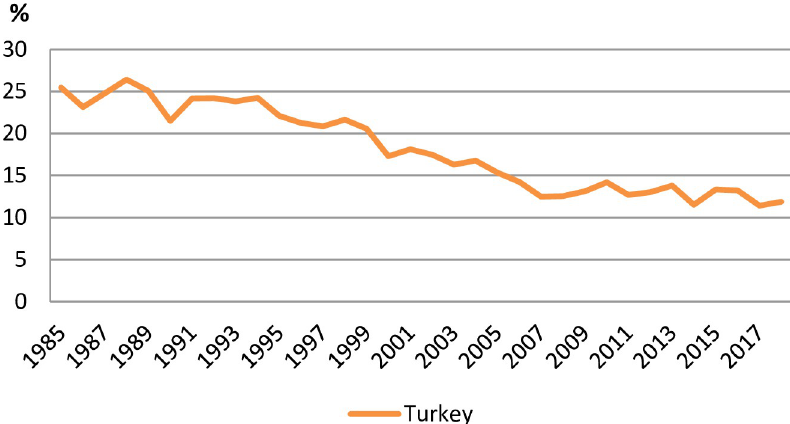
Fig 2. Renewable energy consumption for the period from 1985 to 2018 in Turkey. Source: world